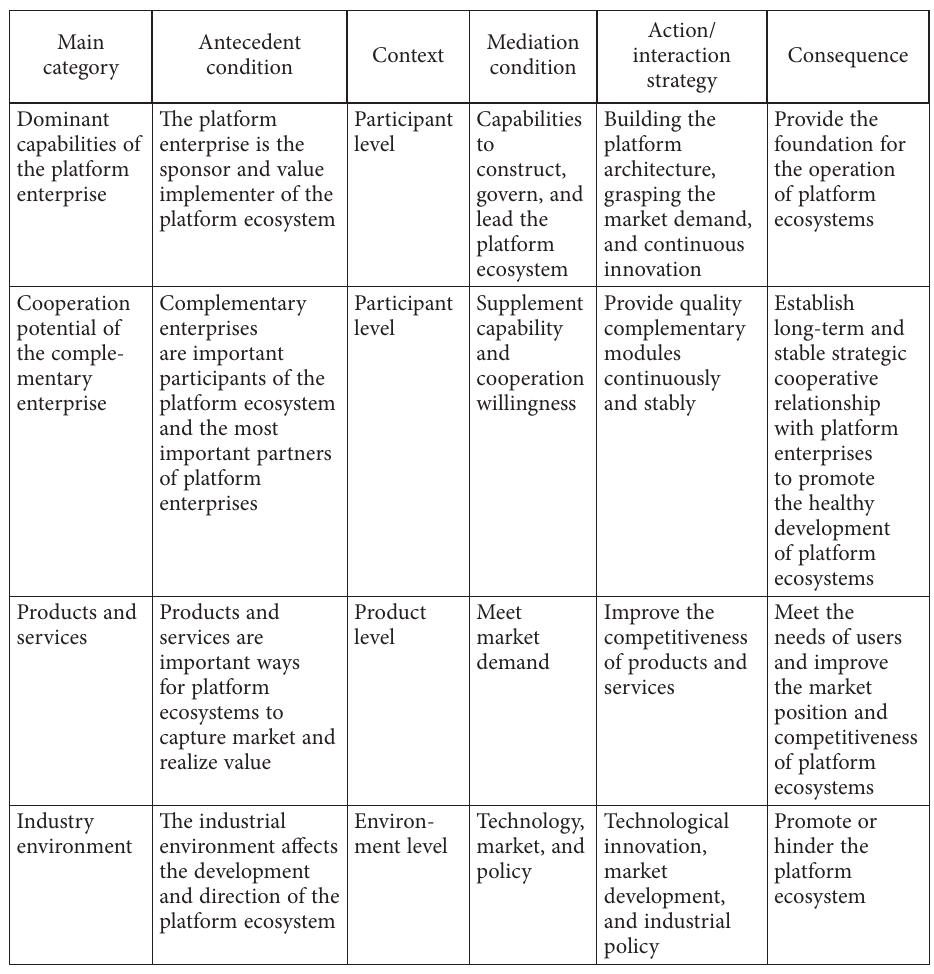
Table 5. Coding paradigms for categories and